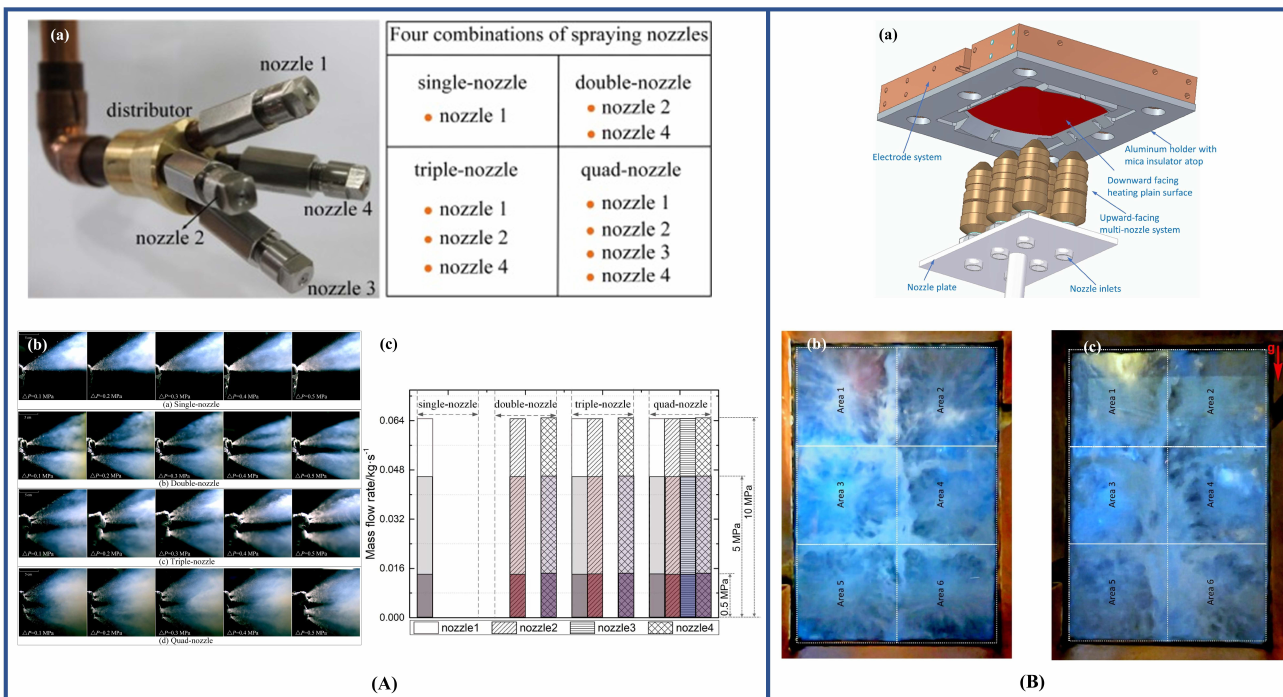
Figure 3. Multi-nozzle combination and characteristics. ( A ): The combination of nozzles used in the experiment ( a ); spray fields of different nozzle versus difference of pressure ( b ); relationship between mass flow distribution and pressure difference for different nozzle combinations ( c ) [71]. ( B ): Details of the SPAYCOR ( a ); spray patterns: 0° inclination ( b ); 90° inclination ( c ). In the figure g is the acceleration of gravity [72].